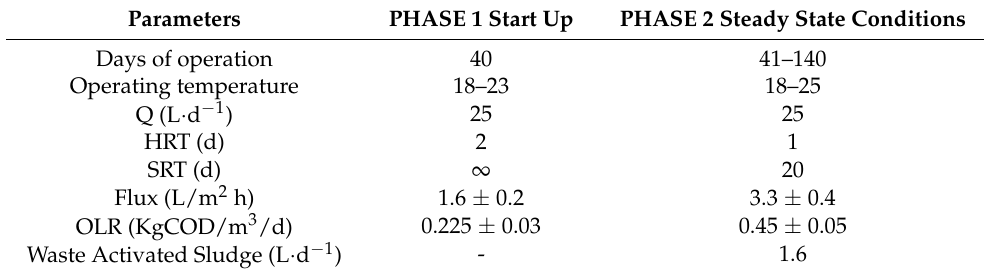
Table 3. Operational parameters of the system.